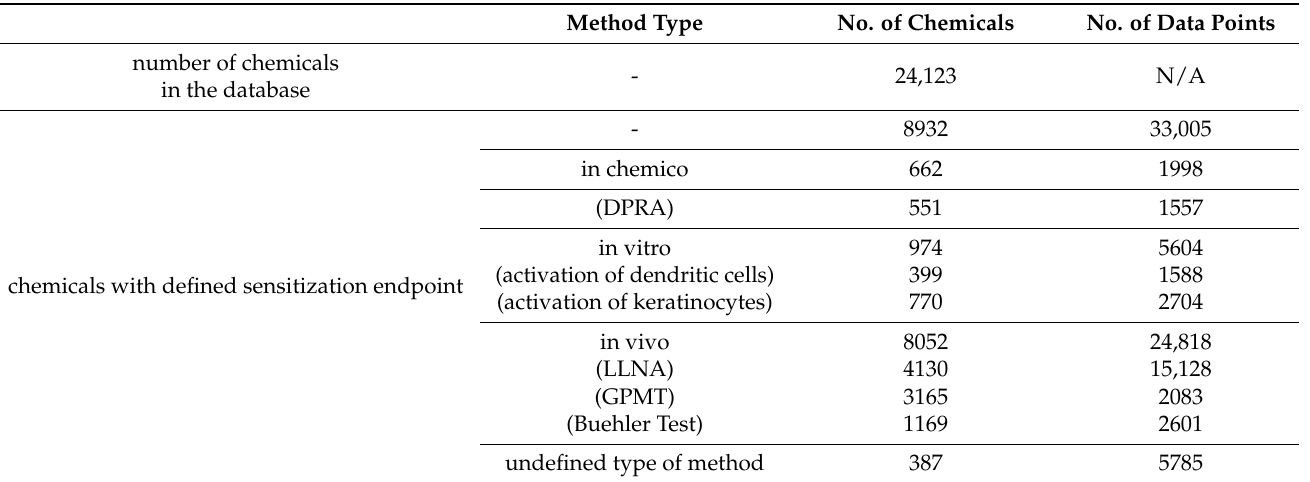
Table 2. The usage frequency of skin sensitisation test methods for REACH registration pur- poses